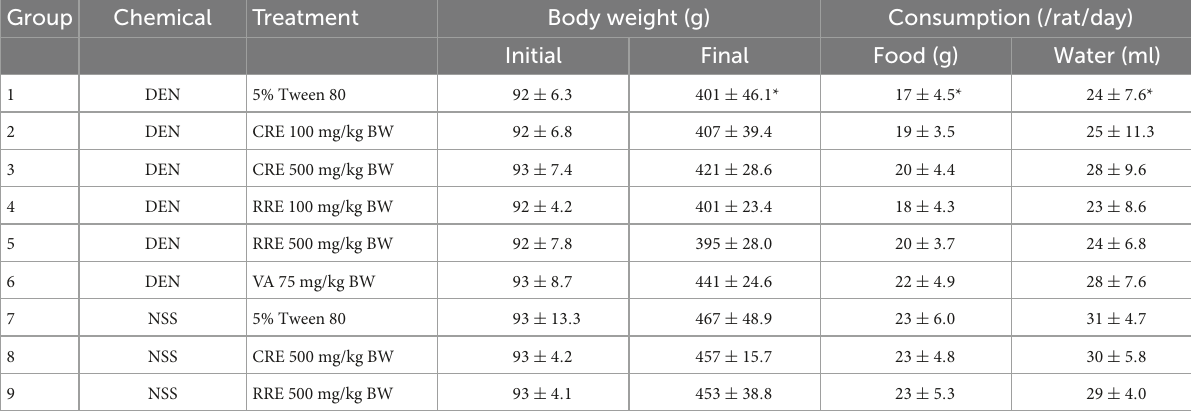
TABLE 3 General observations of medium-term carcinogenicity test on rats for 15 weeks. Group